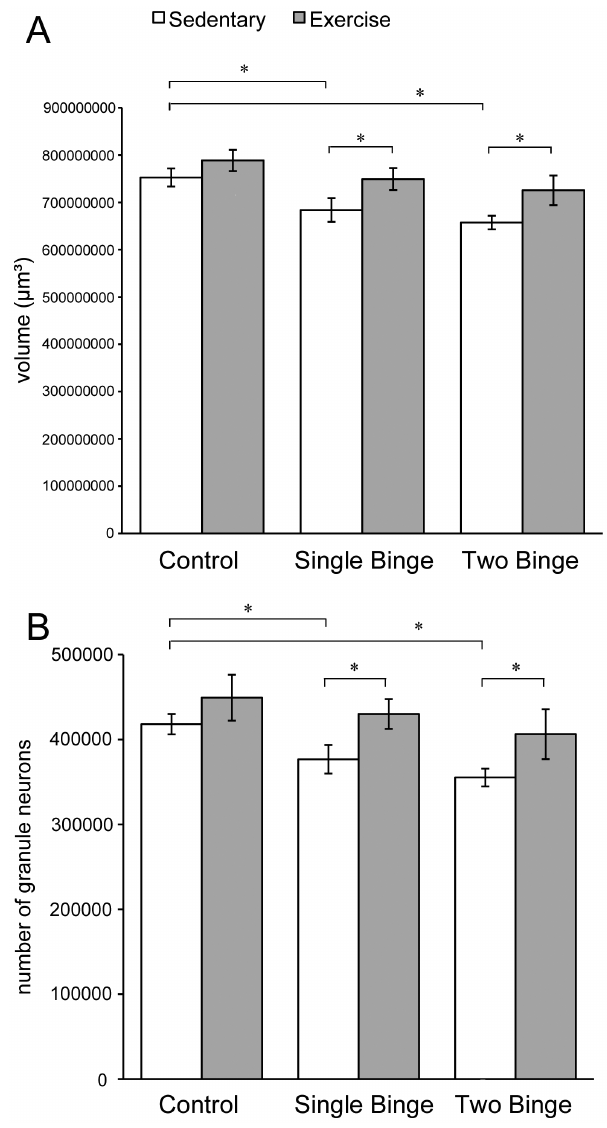
Figure 3. Exercise reversed binge-induced hippocampal dam- age. Both sedentary Single and sedentary Two Binge animals showed a significant reduction in volume of the dentate gyrus (A) and number of remaining granule neurons (B) 35 days after the end of the last binge. Post-binge exercise completely reversed these losses. * p , 0.05